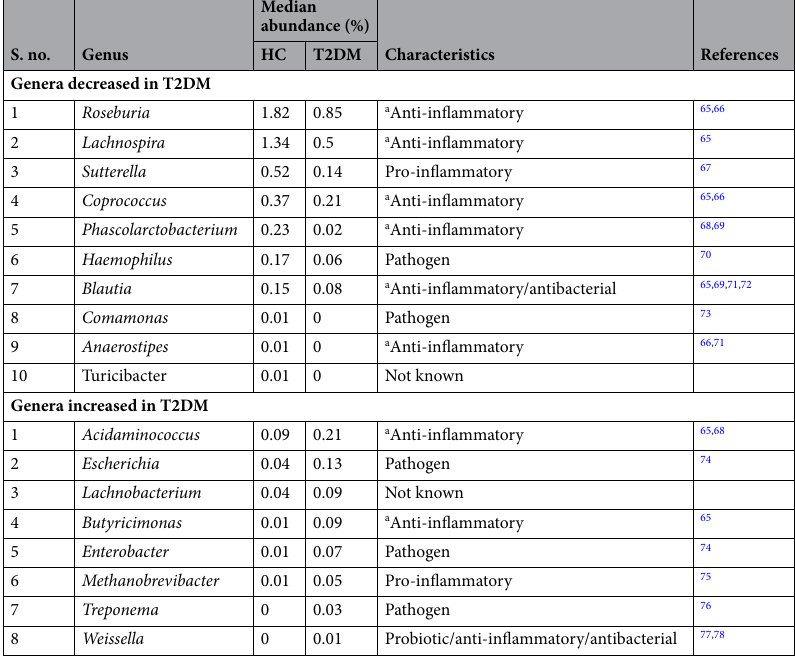
Table 3. Bacterial genera exhibiting significant differential abundance (BH corrected p < 0.05) between the gut microbiomes of healthy controls (HC, n = 30) and type 2 diabetes mellitus (T2DM, n = 24) individuals. a Based on the capability to produce short chain fatty